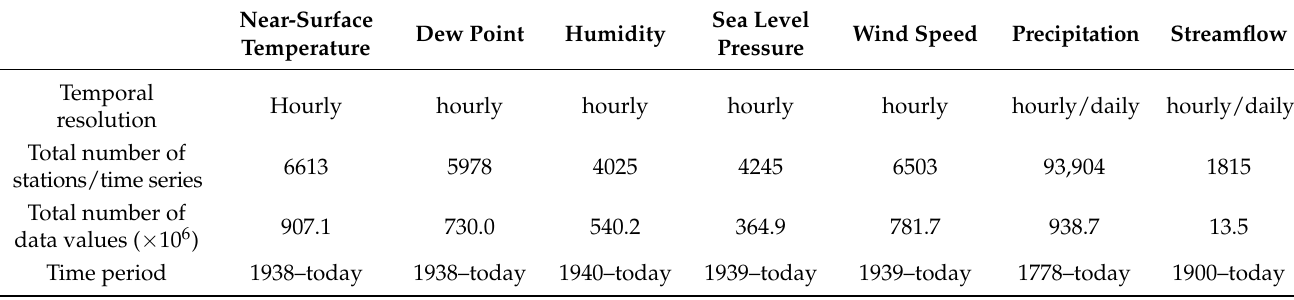
Figure 1. Locations of the selected stations for each hydrological-cycle process: ( a ) near-surface air-temperature; ( b ) relative humidity and dew-point; ( c ) precipitation; ( d ) streamflow; ( e ) wind; and ( f ) sea-level pressure. Table 1. Mean Time Resolution of Each Source, Total Number of Selected Stations and Total Records for Each Hydrological- Cycle Process, and from the Massive Set of Databases. The Humidity Time Series Are Extracted by the Combining the Temperature and Dew-Point Datasets.